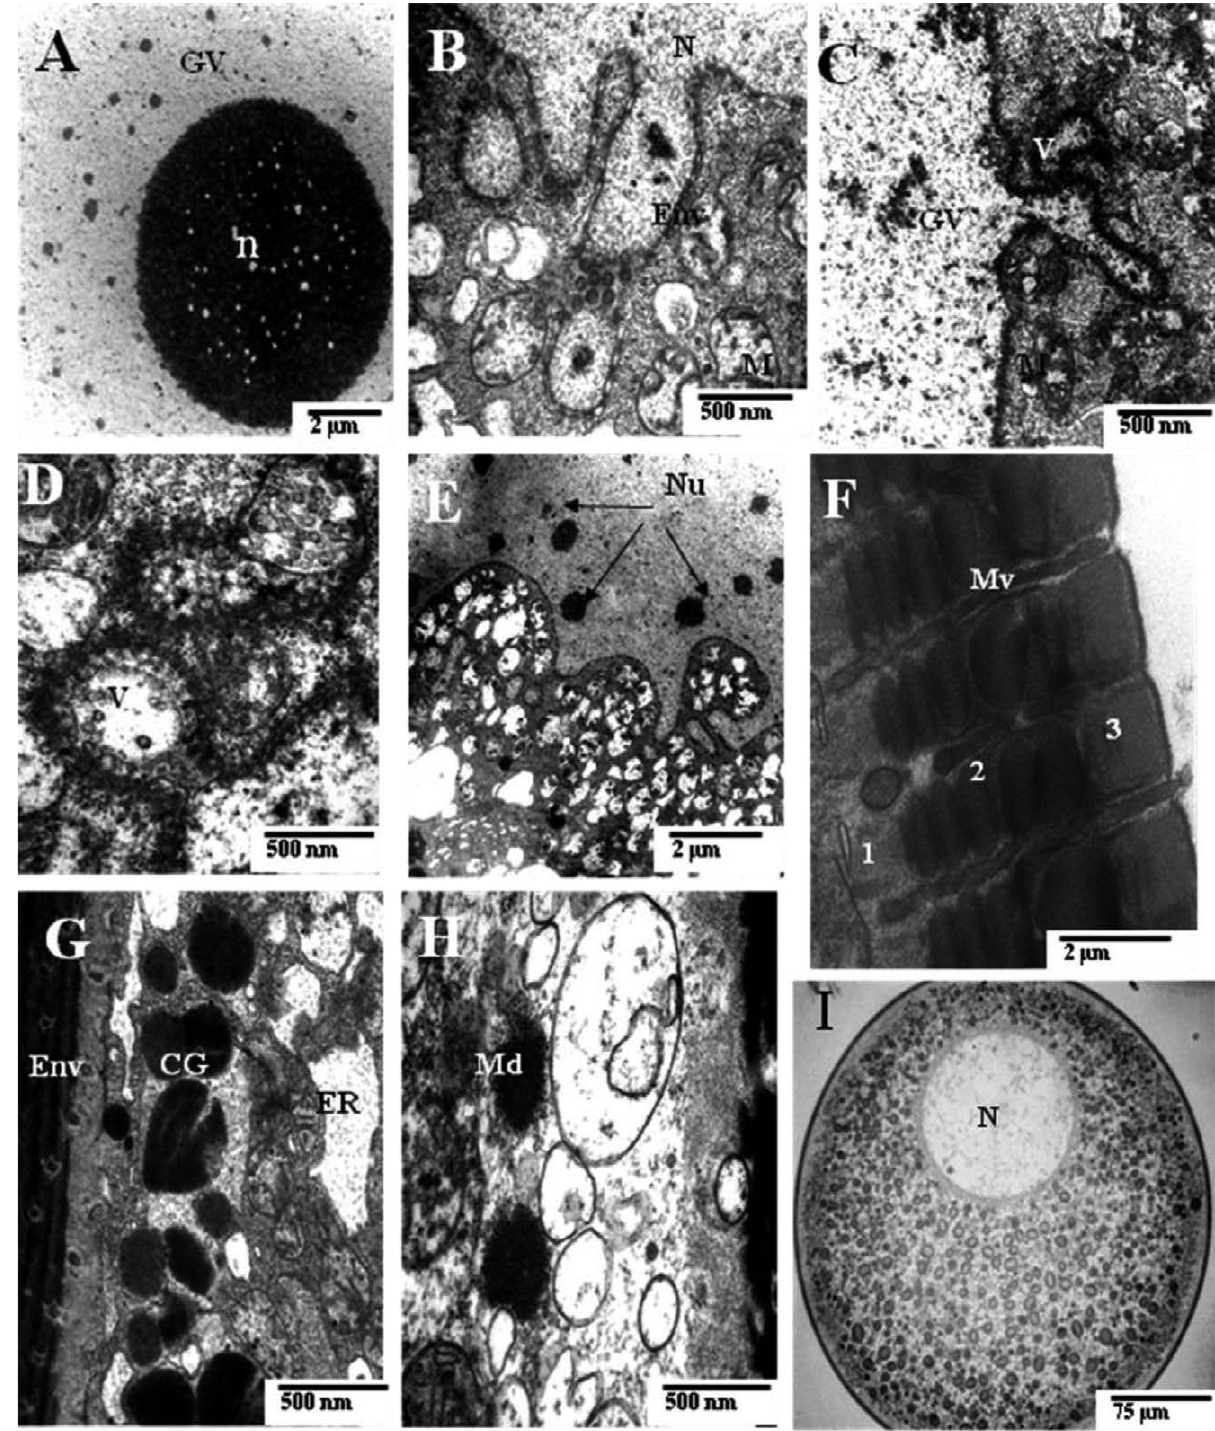
Fig. 10. – A, large nucleolus (n) in eccentric germinal vesicle (GV) of a mature oocyte. B and C, structure of the nuclear envelope (Env) of a mature oocyte; note the irregular outline of the nuclear envelope with many shallow infolding and finger-like extensions into the peri- nuclear ooplasm. D, higher magnification of the nuclear envelope showing the morphology of the flattened vesicles (V). E, germinal vesicle containing perinuclear micro-nucleoli (Nu) (arrows) and mitochondria clustered around the nucleus. F, higher magnification of the vitelline envelope; vitelline envelope consists of thin inner layer (1), middle thicker layer (2) and outer layer (3). G, cortical granules (CG) located in the peripheral ooplam layer of a mature oocyte. H, cortical maternal determinant (Md) located in the animal pole of a mature oocyte. I, TEM of a mature oocyte showing the heterogeneous distribution of yolk bodies and lipid droplets into the cytoplasm. ER, endoplasmic reticulum; M, mitochondria; Mv, microvillus, N,